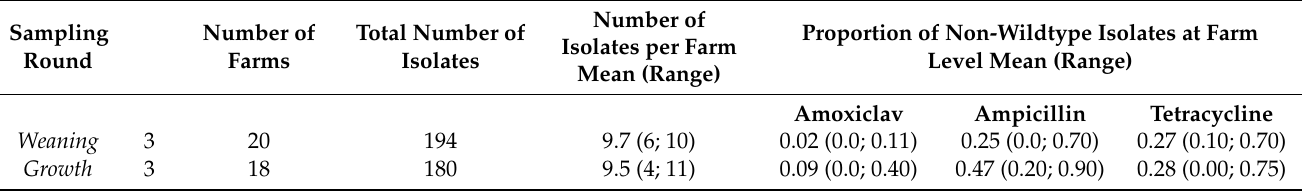
Table 4. Escherichia coli isolates from Danish mink farms collected during two sampling rounds in 2018.